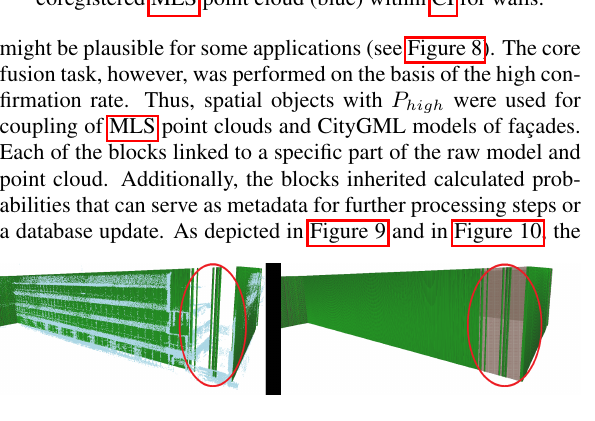
Figure 8. The raw CityGML fac¸ade geometry (gray) and coregistered MLS point cloud (blue) within CI for walls.